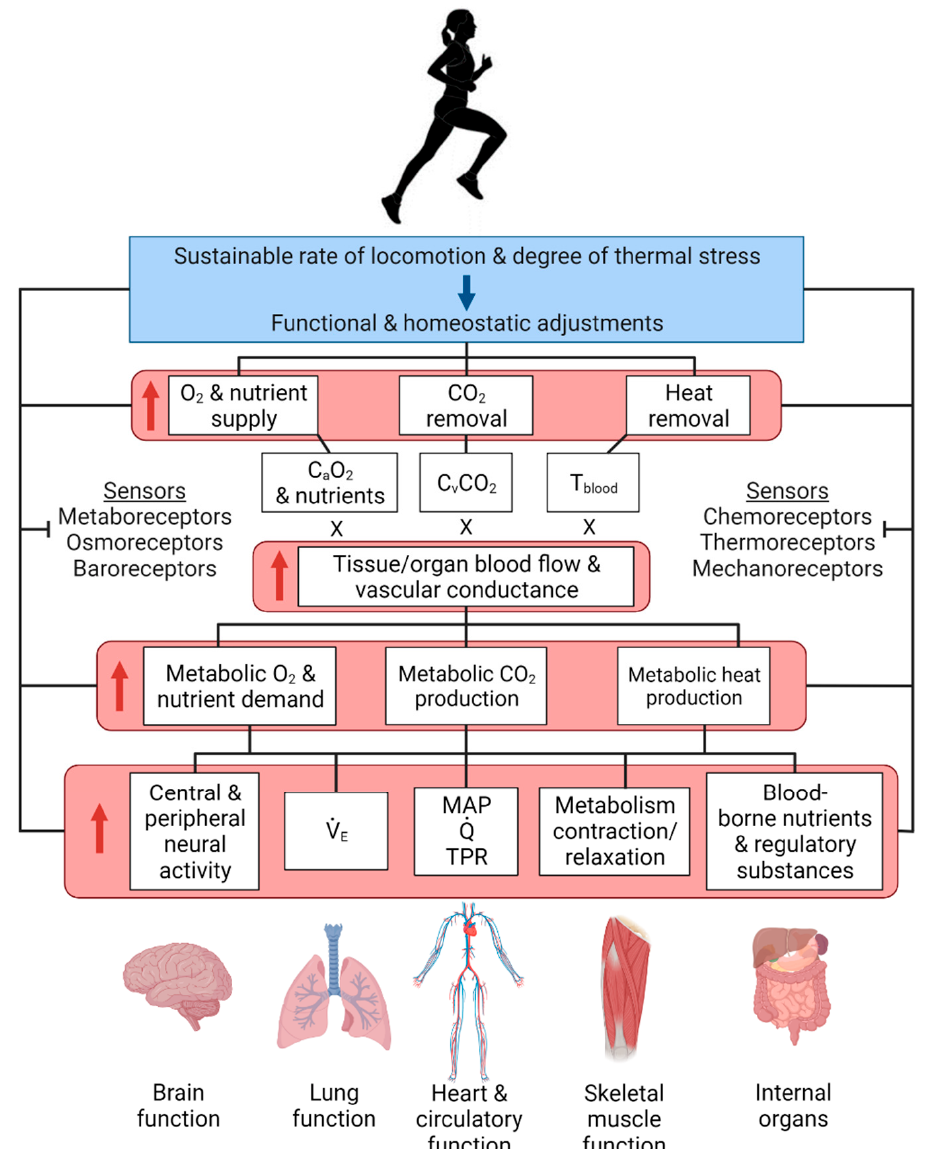
Figure 6. Integrative view of physiological systems during exercise and thermal stress. Increases in the rate of locomotion and the degree of thermal stress induce multiple functional and homeostatic adjustments. These adjustments primarily involve: elevations in O 2 demand and utilisation, and CO 2 and heat production in the working skeletal muscles. The associated rise in muscle blood flow ensures appropriate O 2 supply and CO 2 and heat removal to the surrounding environment via the circulation. These peripheral responses are linked to the increase in central neuromotor drive, pulmonary ventilation, systemic blood flow and arterial pressure, and are underpinned by elevations in central and skeletal muscle neural activity, as well as global respiratory, vascular and cardiac function. Cellular homeostasis is preserved across all organ systems when the physiological demand of exercise and thermal stress is substantially below the body’s functional capacity. Created with BioRender.com.